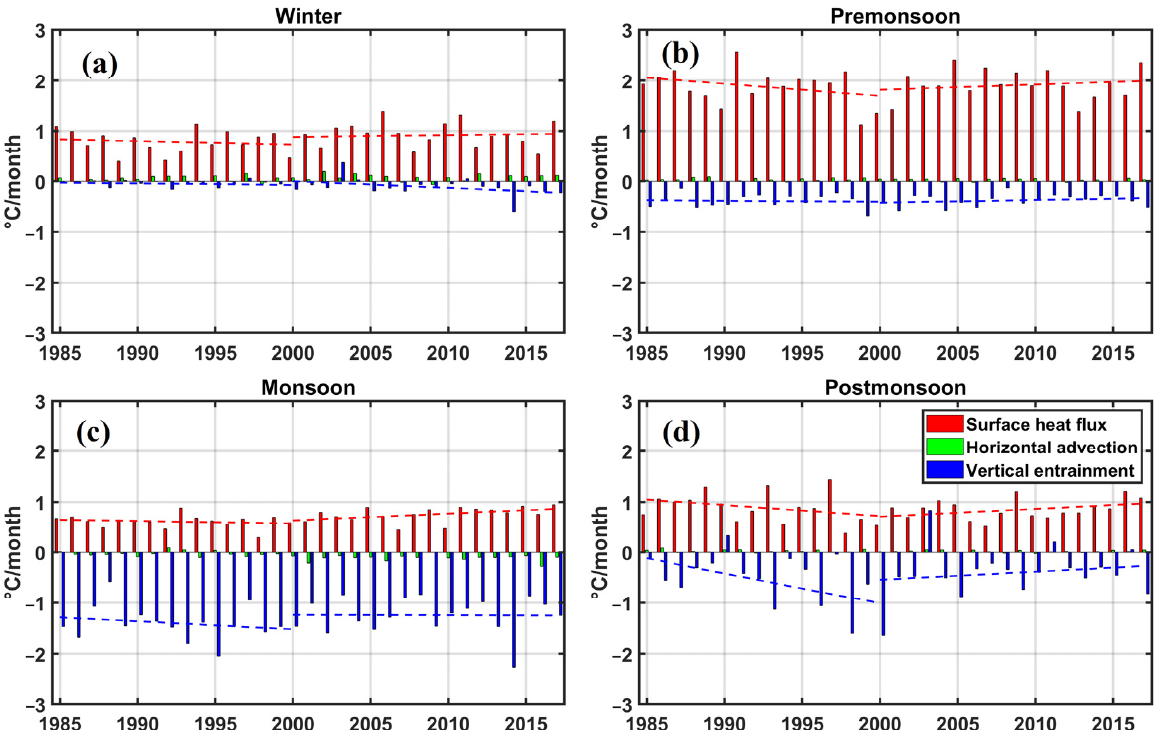
Figure 12. Trend analysis of heat budget terms in different seasons ( a ) winter, ( b ) pre-monsoon, ( c ) monsoon, and ( d ) post-monsoon.